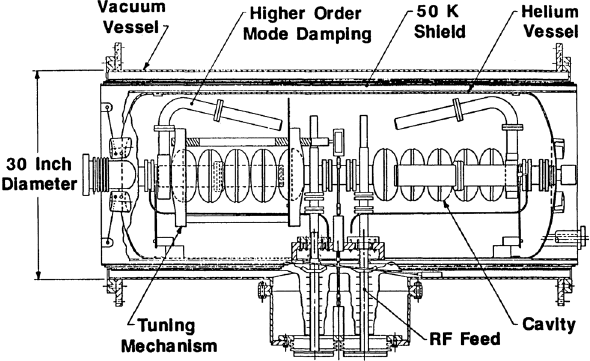
FIG. 1. CEBAF cryounit configuration (from